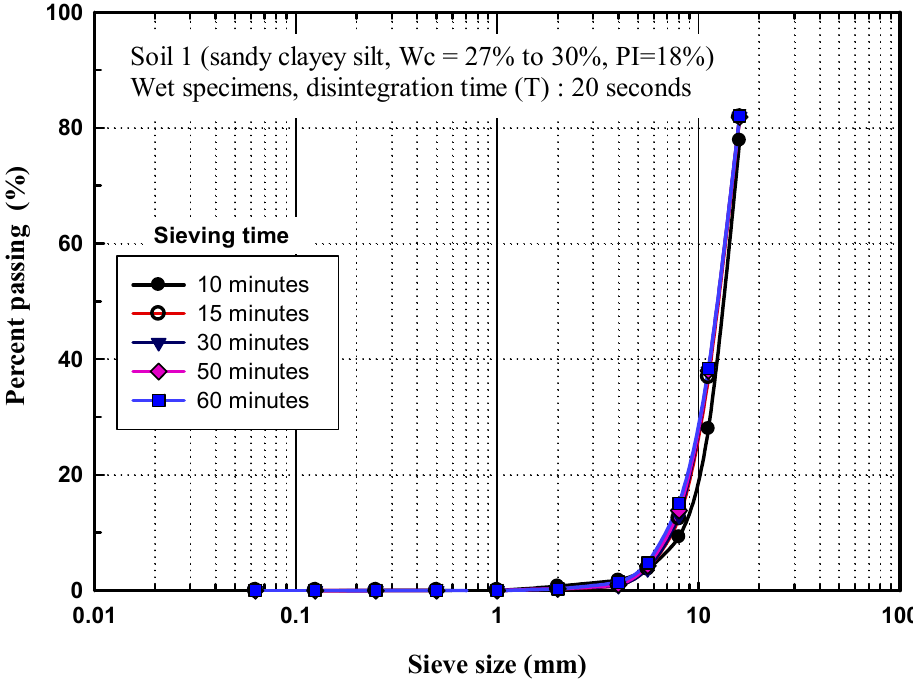
Figure 7. Percentage passing through versus sieve size for wet Soil 1 specimen sieved at various times.